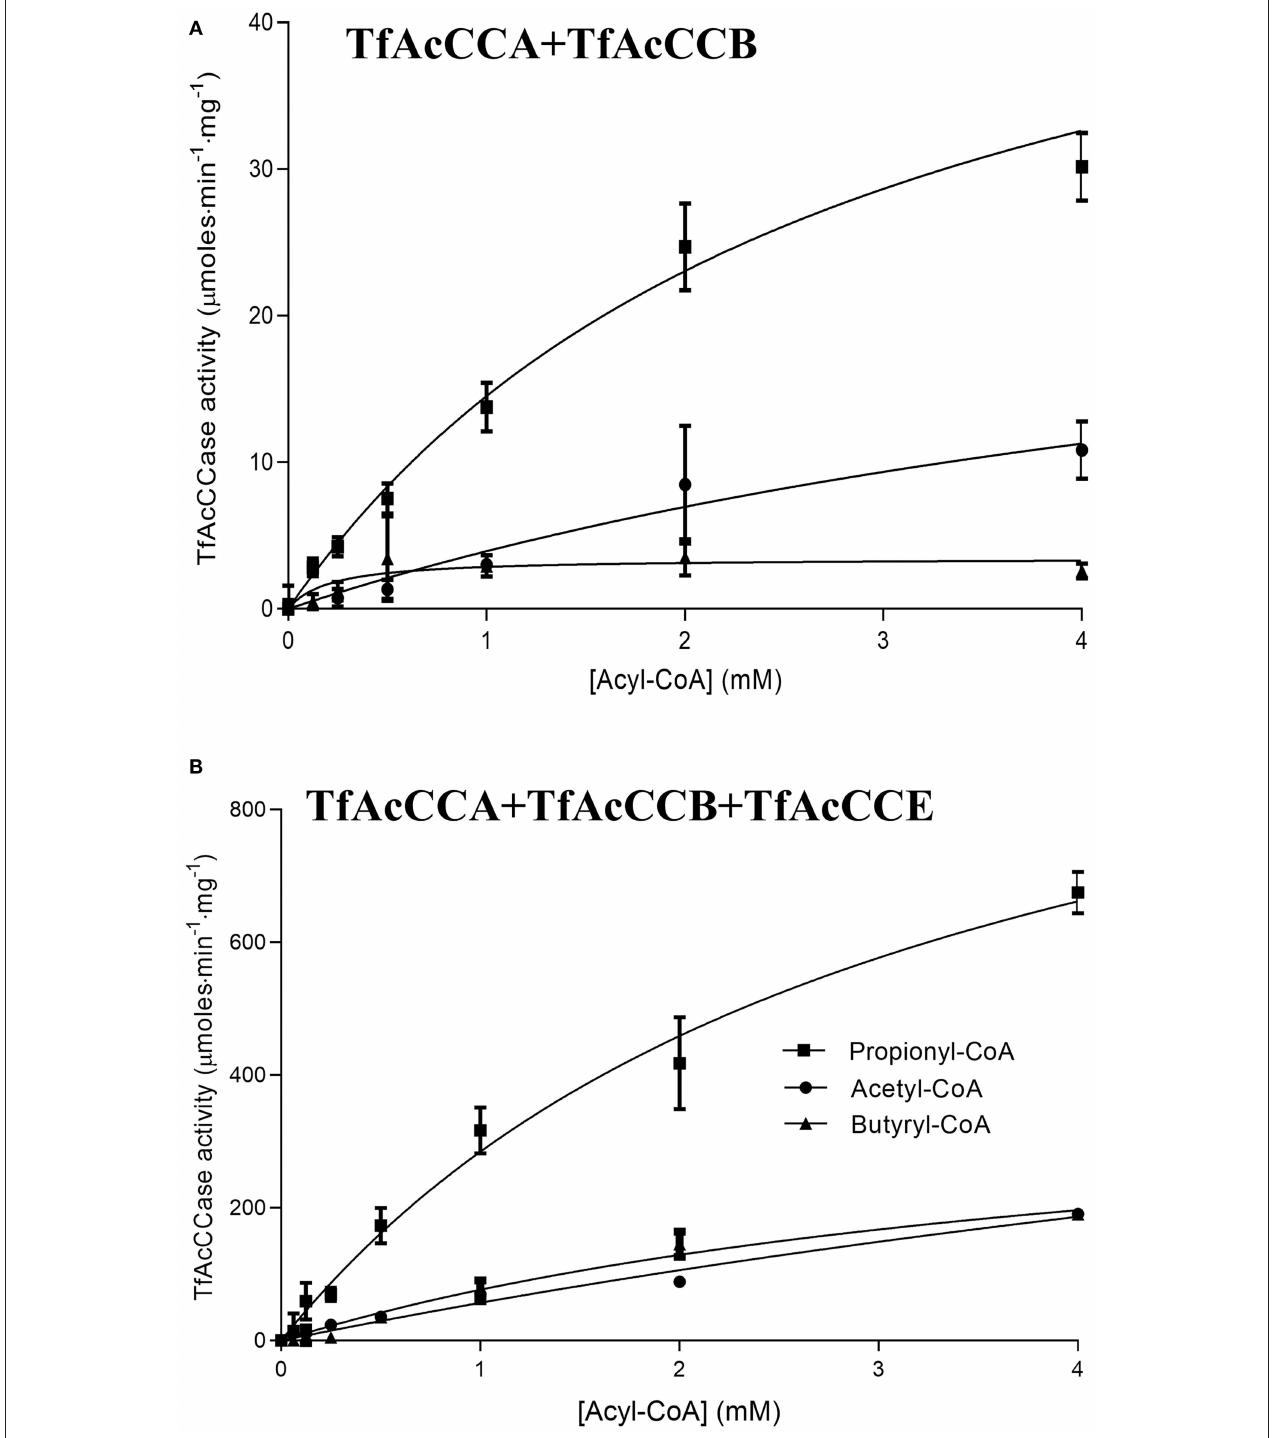
FIGURE 3 | Acyl-CoA dependence of the carboxylation reaction catalyzed by TfAcCCase preparations in the absence (A) or presence (B) of the TfAcCCE subunit. Data-points are the average of triplicate assays ( + SE) with either acetyl-CoA, propionyl-CoA or butyryl-CoA as the substrate. These experiments were conducted with two different enzyme